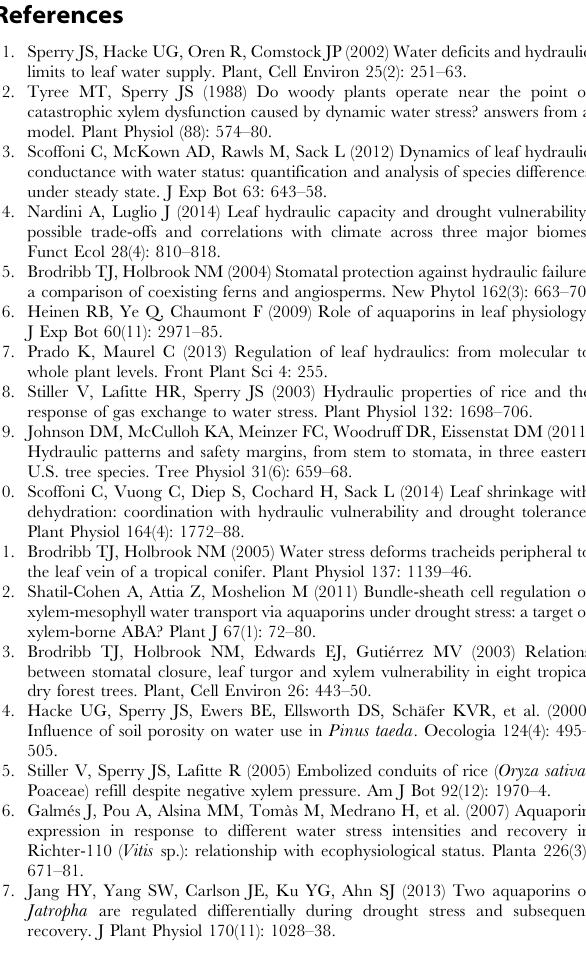
Populus trichocarpa PtPIP1s; (b) of the conserved the C-terminal region of PIP2s, and (c) TIP2s. Consensus amino acids are underlined in black. (DOCX) Figure S2 Transverse section of a Populus trichocarpa leaf showing minor veins with (left) and without (right) bundle sheath cell extensions. Scale bar= 20 m m. Table S1 Primer sequences used for the gene expres- sion